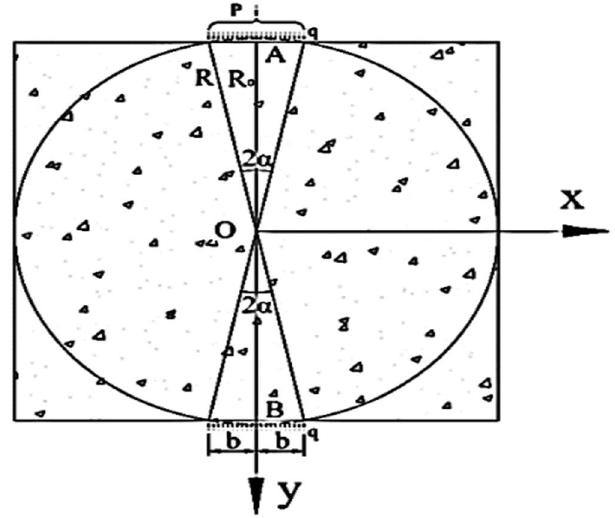
Figure 4. Mechanical model of the indirect tensile test of the interlayer bond.